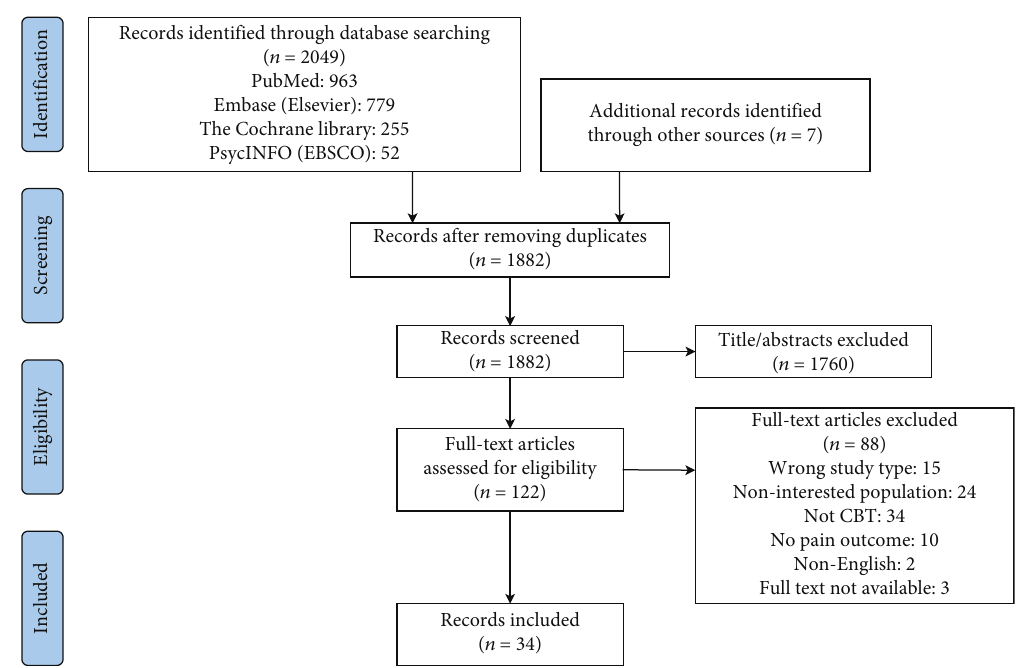
Figure 2: Flow chart for selection